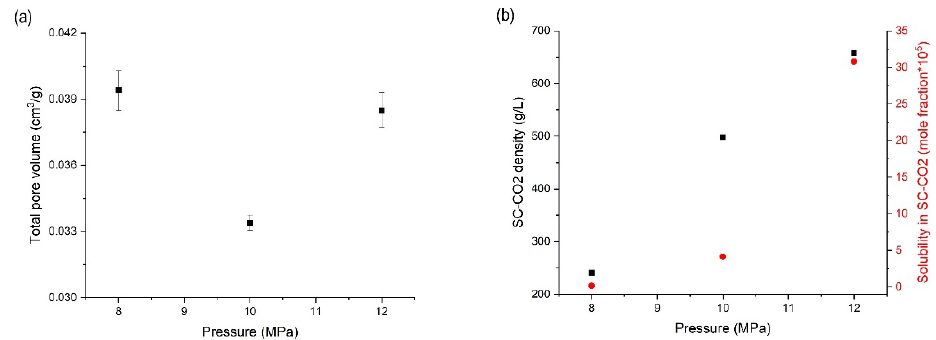
Figure 5. ( a ) Change in total pore volume with increasing pressure at 318.15 K and ( b ) the correlation of pressure to SC-CO 2 density and solubility of orlistat in SC-CO 2 .